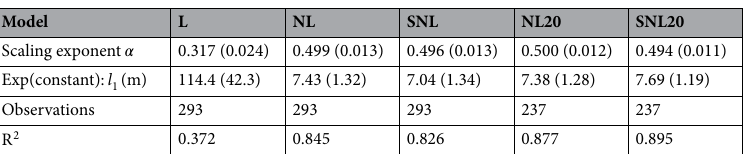
Table 1. Results of a linear fit of the fitted (log) characteristic distance l N against the (log) total population N , ) for the different models: linear fit (L), two-parameter and one-parameter non- log ( l N ) ∼ 𝛼 log ( N ) + log ( l 1 linear fits (models NL and SNL respectively) on all cities, and fits on continental cities only (models NL20 and SNL20, resp.). Note that we exponentiated the second fitted coefficient in this table to obtain the distance l l 1 (and its standard error) in meters, which is easier to interpret. 1 can be seen as the characteristic size of a theoretical city 5 housing one person ( N = 1